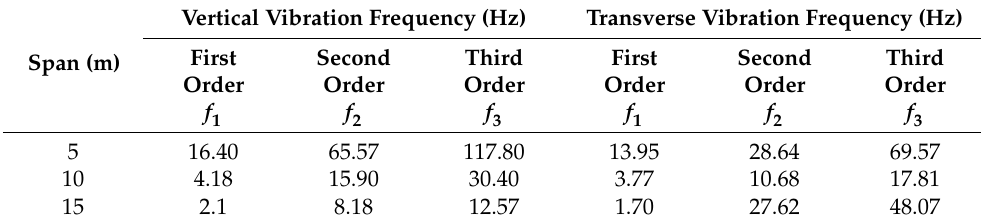
Table 3. Summary of fundamental frequency calculation